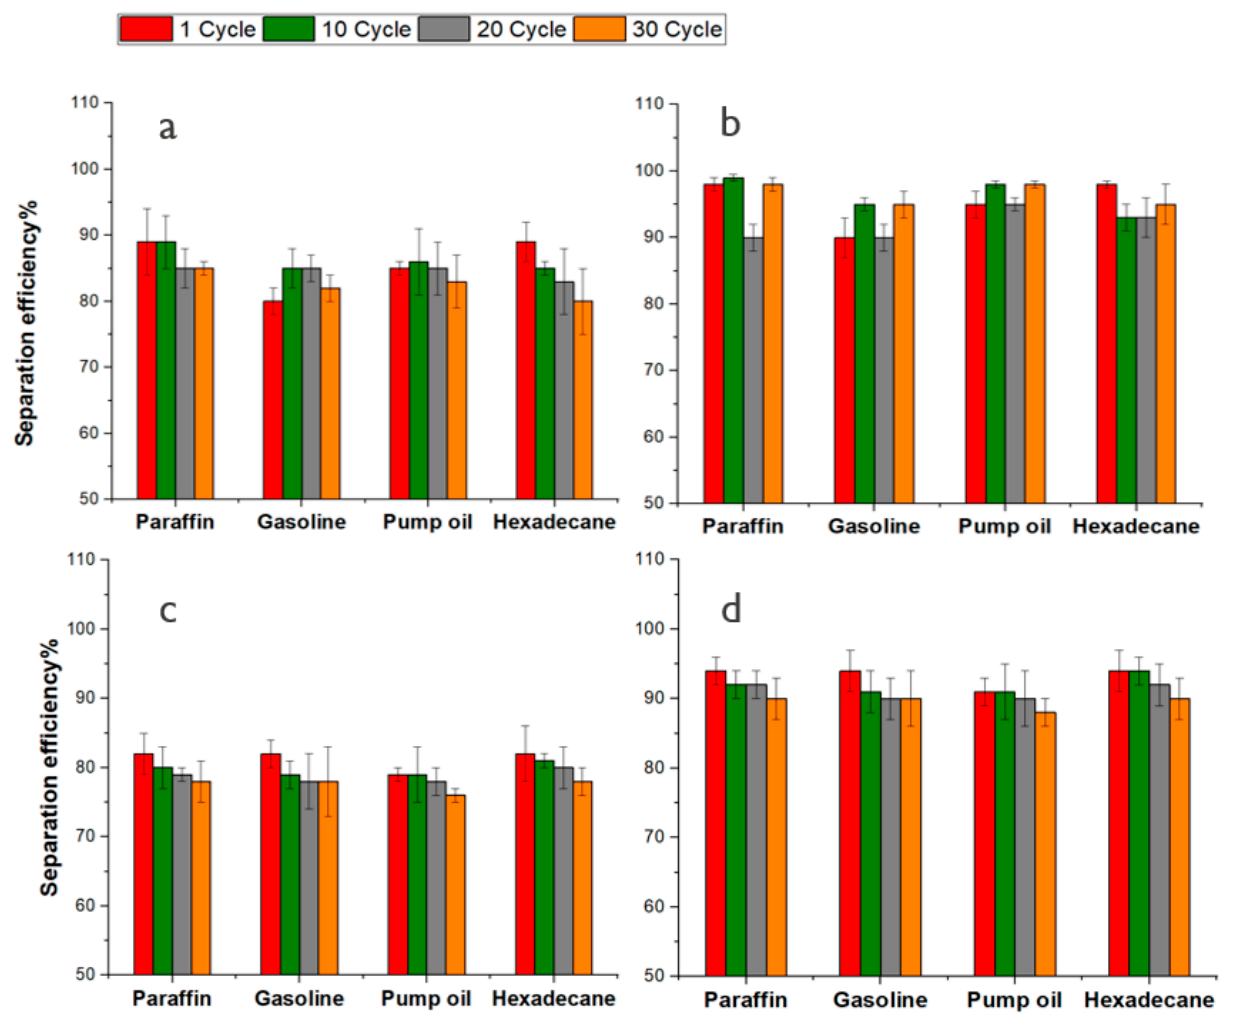
Figure 8. The separation efficiency of ( a ) Si-Cot_Dip ( b ) Si-Cot_Dip/O 2 ( c ) Si-Cot_Plasma ( d ) Si- Cot_Plasma/O 2 at 90 °C for several oil /water mixtures, after different cycles.